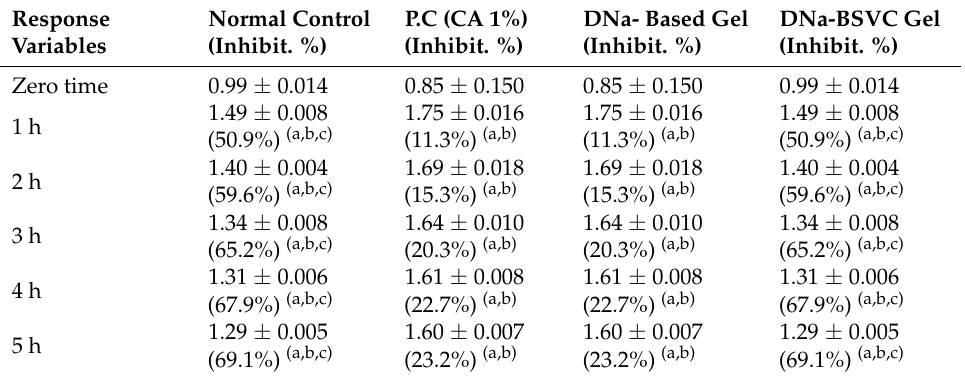
Table 6. Effect of DNa-BSVC gel on % increase paw edema volume measured for 5 h period prior to rats being subjected to carrageenan injection.